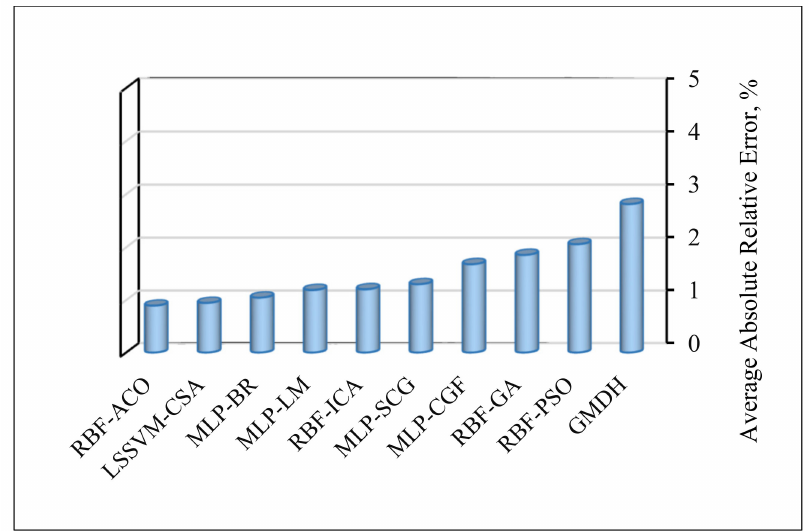
Figure 10. Average absolute percent relative error (AAPRE) for the asphaltenes adsorption models proposed in this research.